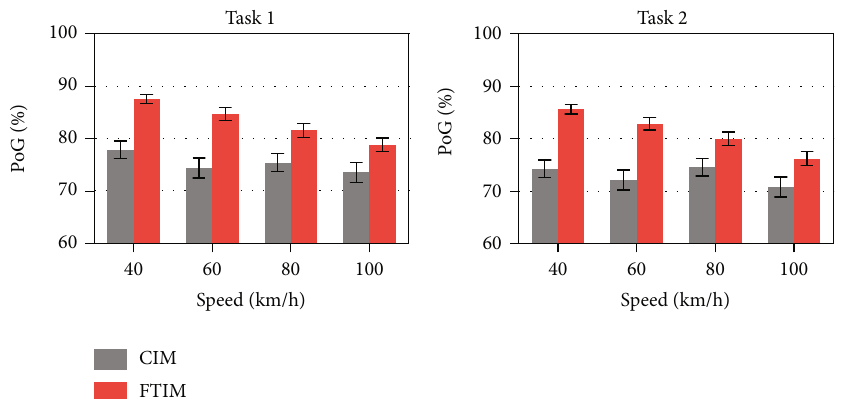
Figure 8: PoG for two tasks by interaction mode and vehicle speed.